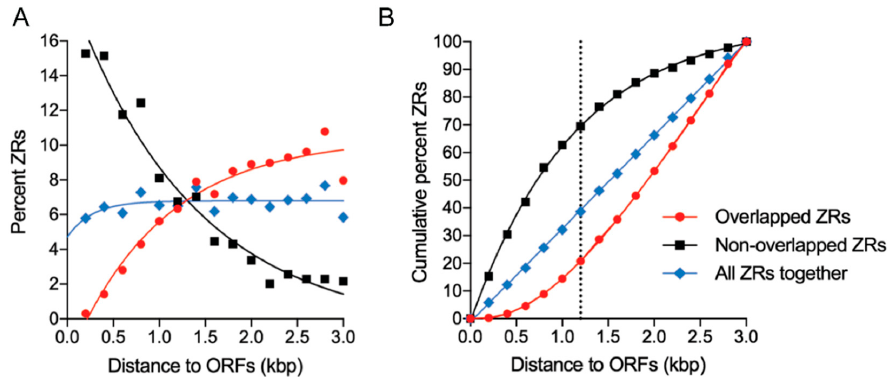
Figure 8. Distribution of ZR motifs at a genome scale in the upstream regions of the predicted open reading frames (ORFs). ( A ) Representation of the percentage of ZR motifs (overlapped, non-overlapped and all together) with respect to their distance to the predicted translation start codons (TSC) of the ORFs; ( B ) representation of the cumulative percent of ZR motifs with respect to their distance to the predicted translation start codons of the ORFs. The dotted line indicates the average size of the DNA sequence that is located upstream of the predicted TSCs containing the ZR motifs with the highest probability of being involved in regulating gene expression (i.e., the functionally relevant ZR motifs). In both graphs, the distance of the ZR motifs to the ORFs represented on the x-axes was divided into 15 fractions of 200 bp each.